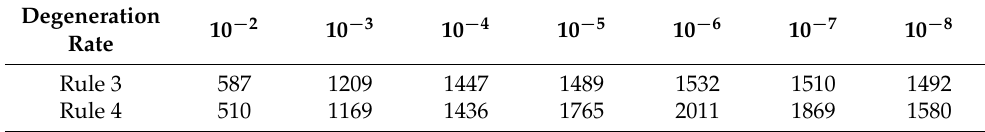
Table 3. Effect of degeneration rate on low-probability password hits (Rules 3 and 4).